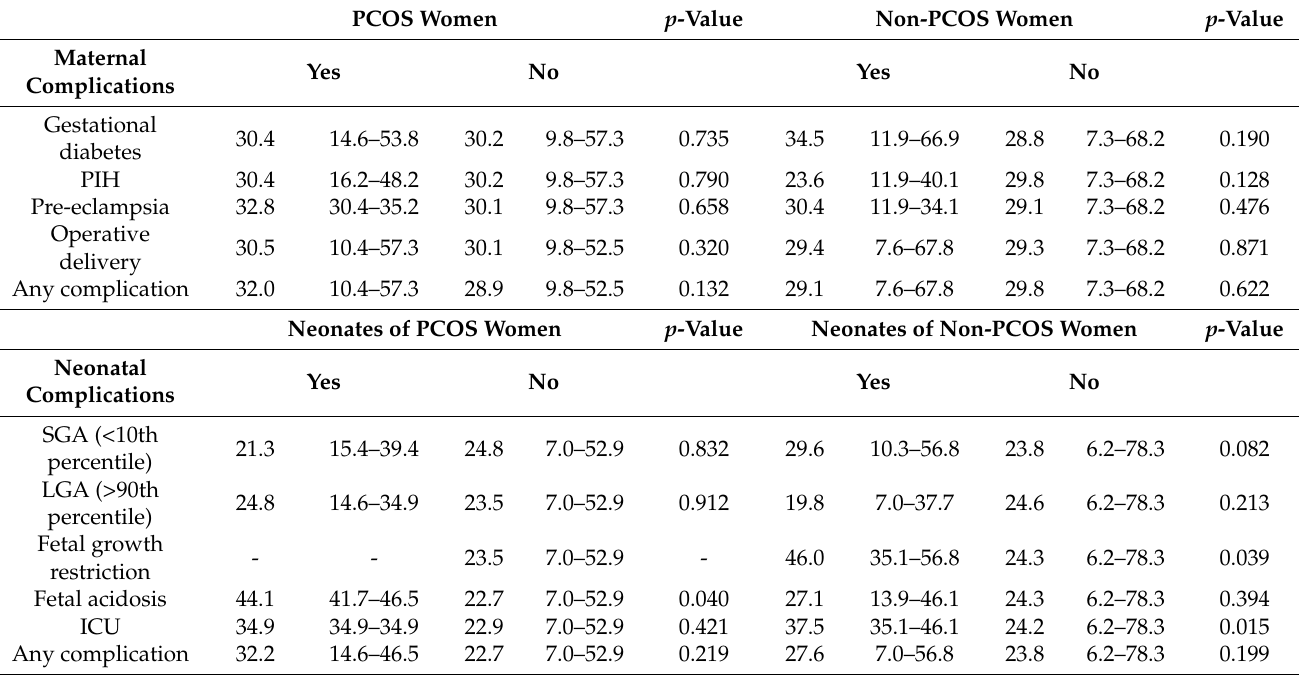
Table 2. Association between 25(OH)D levels and maternal and neonatal complications in PCOS and Non- PCOS pregnancies. PCOS Women p -Value Non-PCOS Women p -Value